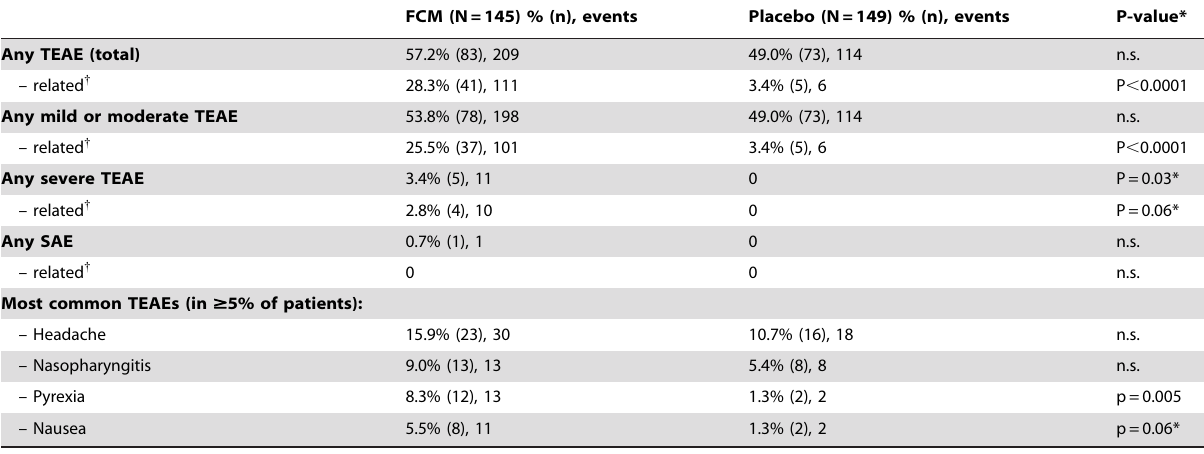
Table 5. Adverse events profile